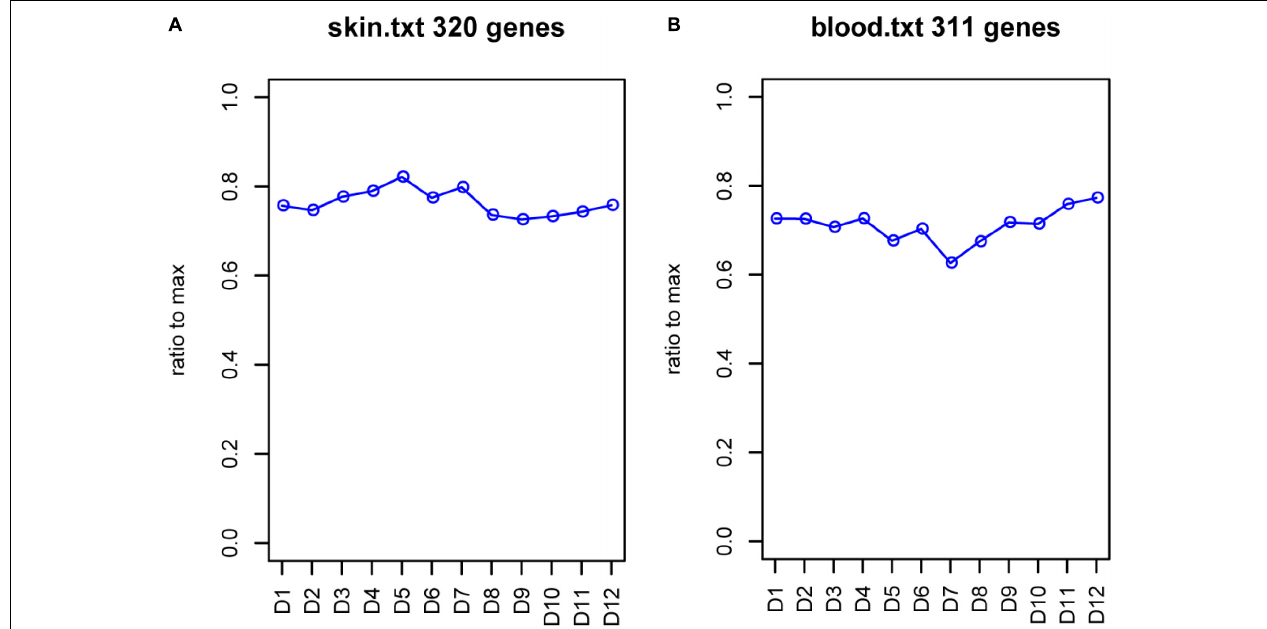
FIGURE 9 | FPKM of sulfur metabolism genes. (A) FPKM of sulfur metabolism genes in skin. (B) FPKM of sulfur metabolism genes in blood. Abscissa represents month, and ordinate represents ratio to max. D represents the control